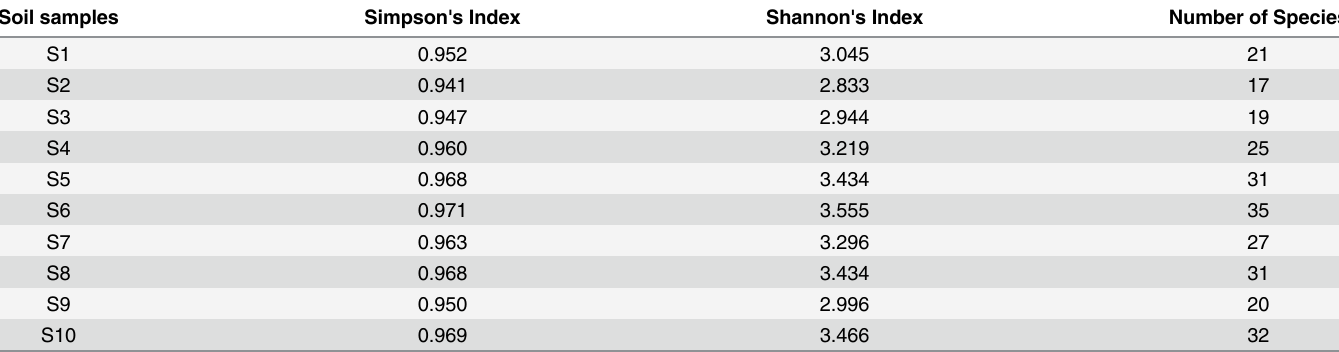
Soil samples were labeled as Table 2. S1, CK1-Single peanut, S2, CK2-Single buckwheat, S3, CK3-Single sorghum, S4,CK4-Single glutinous millet, S5,